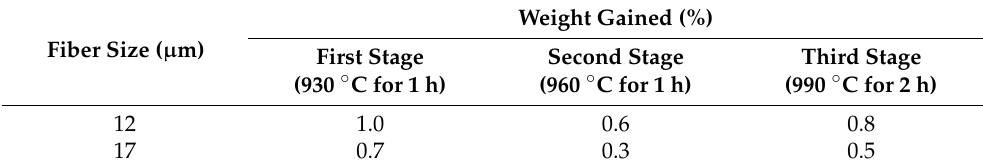
Figure 1. Percentage weight change of the 12 and 17 μm FeCrAl fibers versus temperature during the first MSHT cycle. Table 3. Percentage of weight gains during each stage of the first MSHT cycle for the 12 and 17 µm FeCrAl fibers.